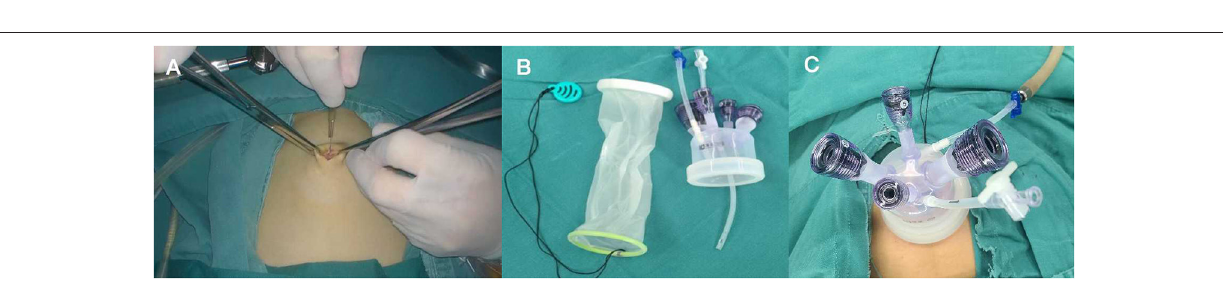
posterior peritoneum was gently raised toward the umbilical incision. Using a purse-string suture, the suspended posterior peritoneum was held in place and marked. Afterwards, the center